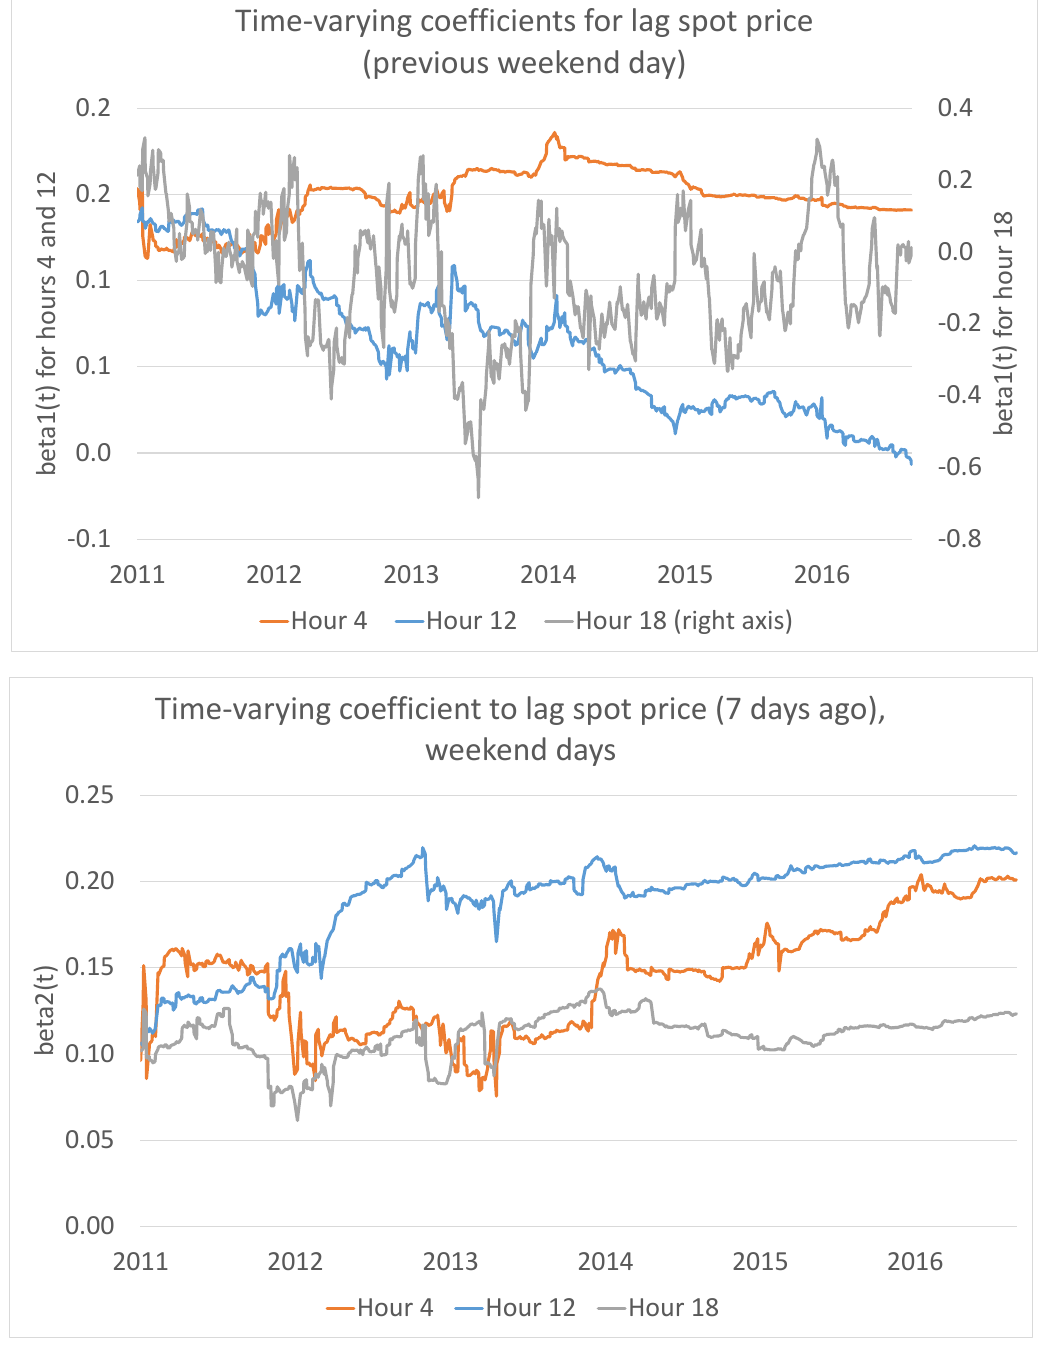
Figure 10. Time-varying coefficients of the lagged spot price variable, same hour, previous weekend day, and the seven-day-lagged price (same hour, one week ago). The coefficients have been estimated for the sample period from 1 January 2011 until 31 August 2016 with respect to the key hours H4, H12 and H18 on working